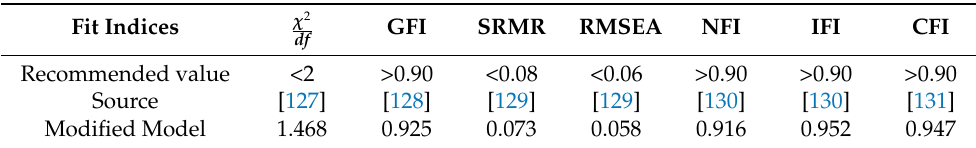
Table 6. Fit summary of criteria and initial model.